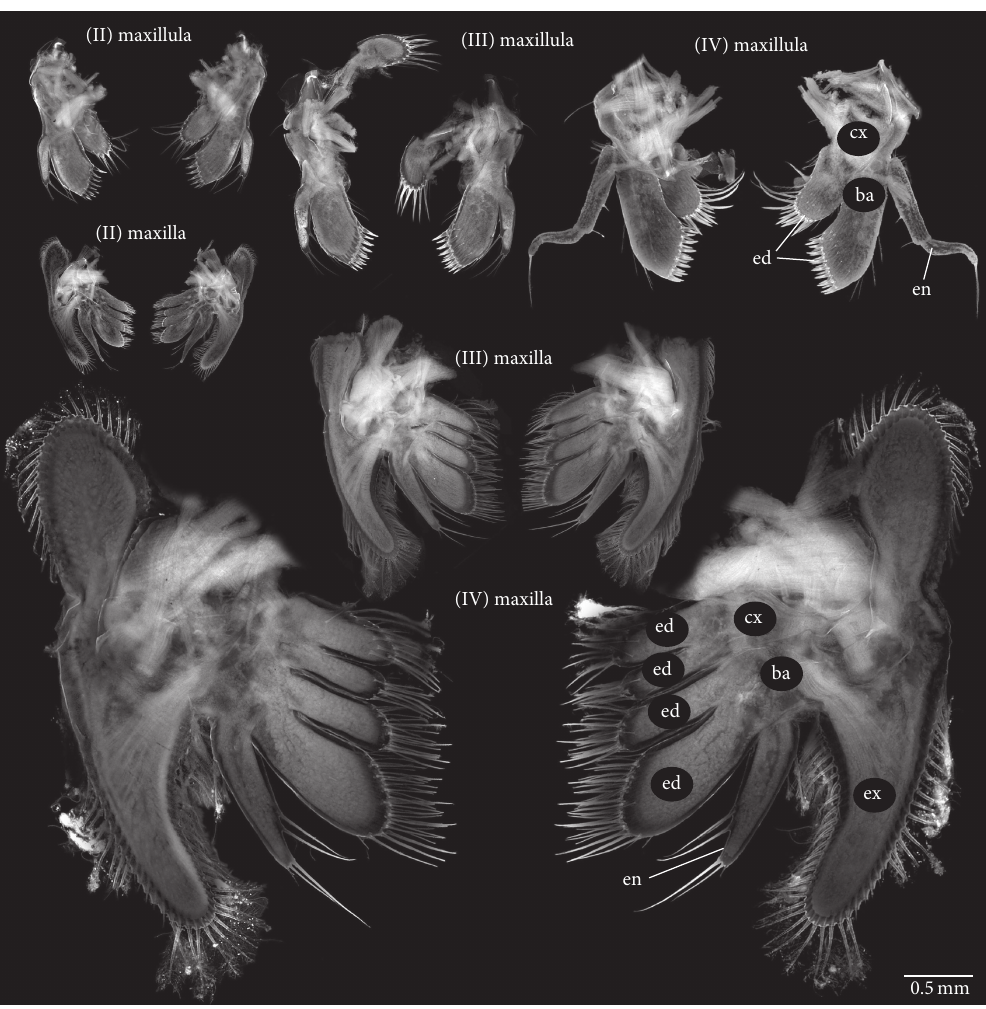
Figure 5: Maxillula and maxilla of larval stages (II) to (IV) of Homarus gammarus . Right appendage in anterior (left) and posterior (right) view, besides (II) maxillula, which is a left one flipped. Labeling only given in one instance due to the similarity of the structures throughout all stages. ba = basipod; cx = coxa; ed = endite; en = endopod; ex =